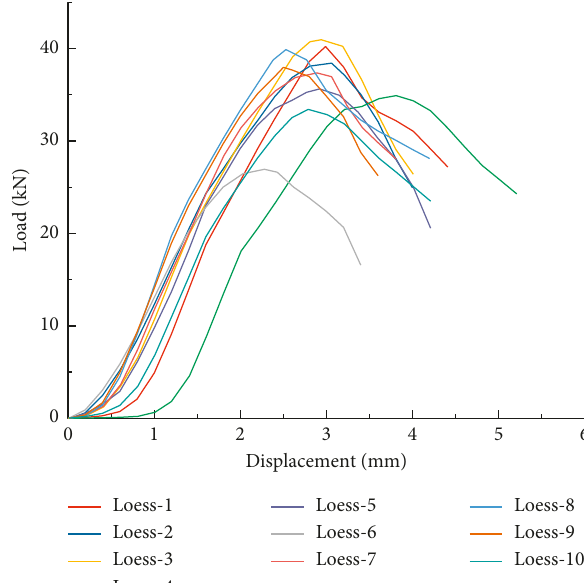
Figure 10: Load-displacement curve of